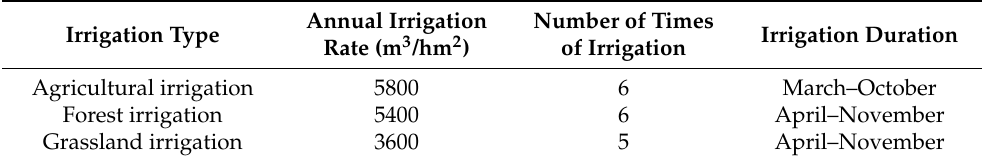
Table 1. Irrigation volume in the study region.